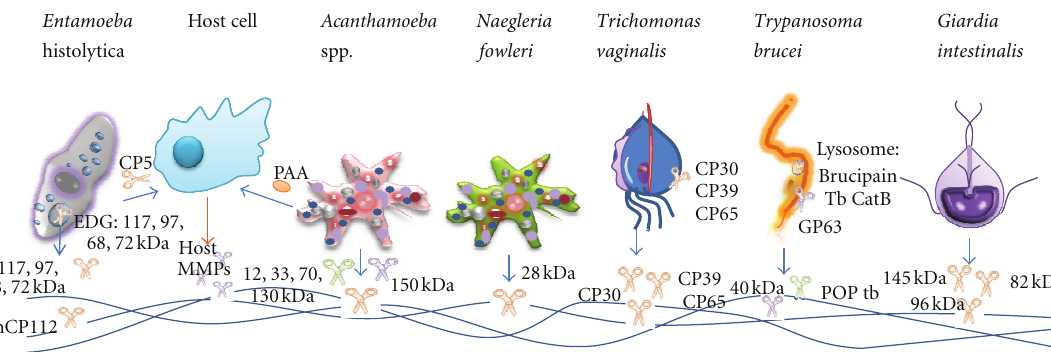
Figure 1: Extracellular parasite proteases. CPs: cysteine proteases, pink scissors; SPs: serine proteases, green scissors; MMPs: matrix metalloproteases, blue scissors; ECM extracellular matrix; EDG: electron-dense granules; POP: prolyl oligopeptidase; PAA: plasminogen activator activity; CatB: cathepsin